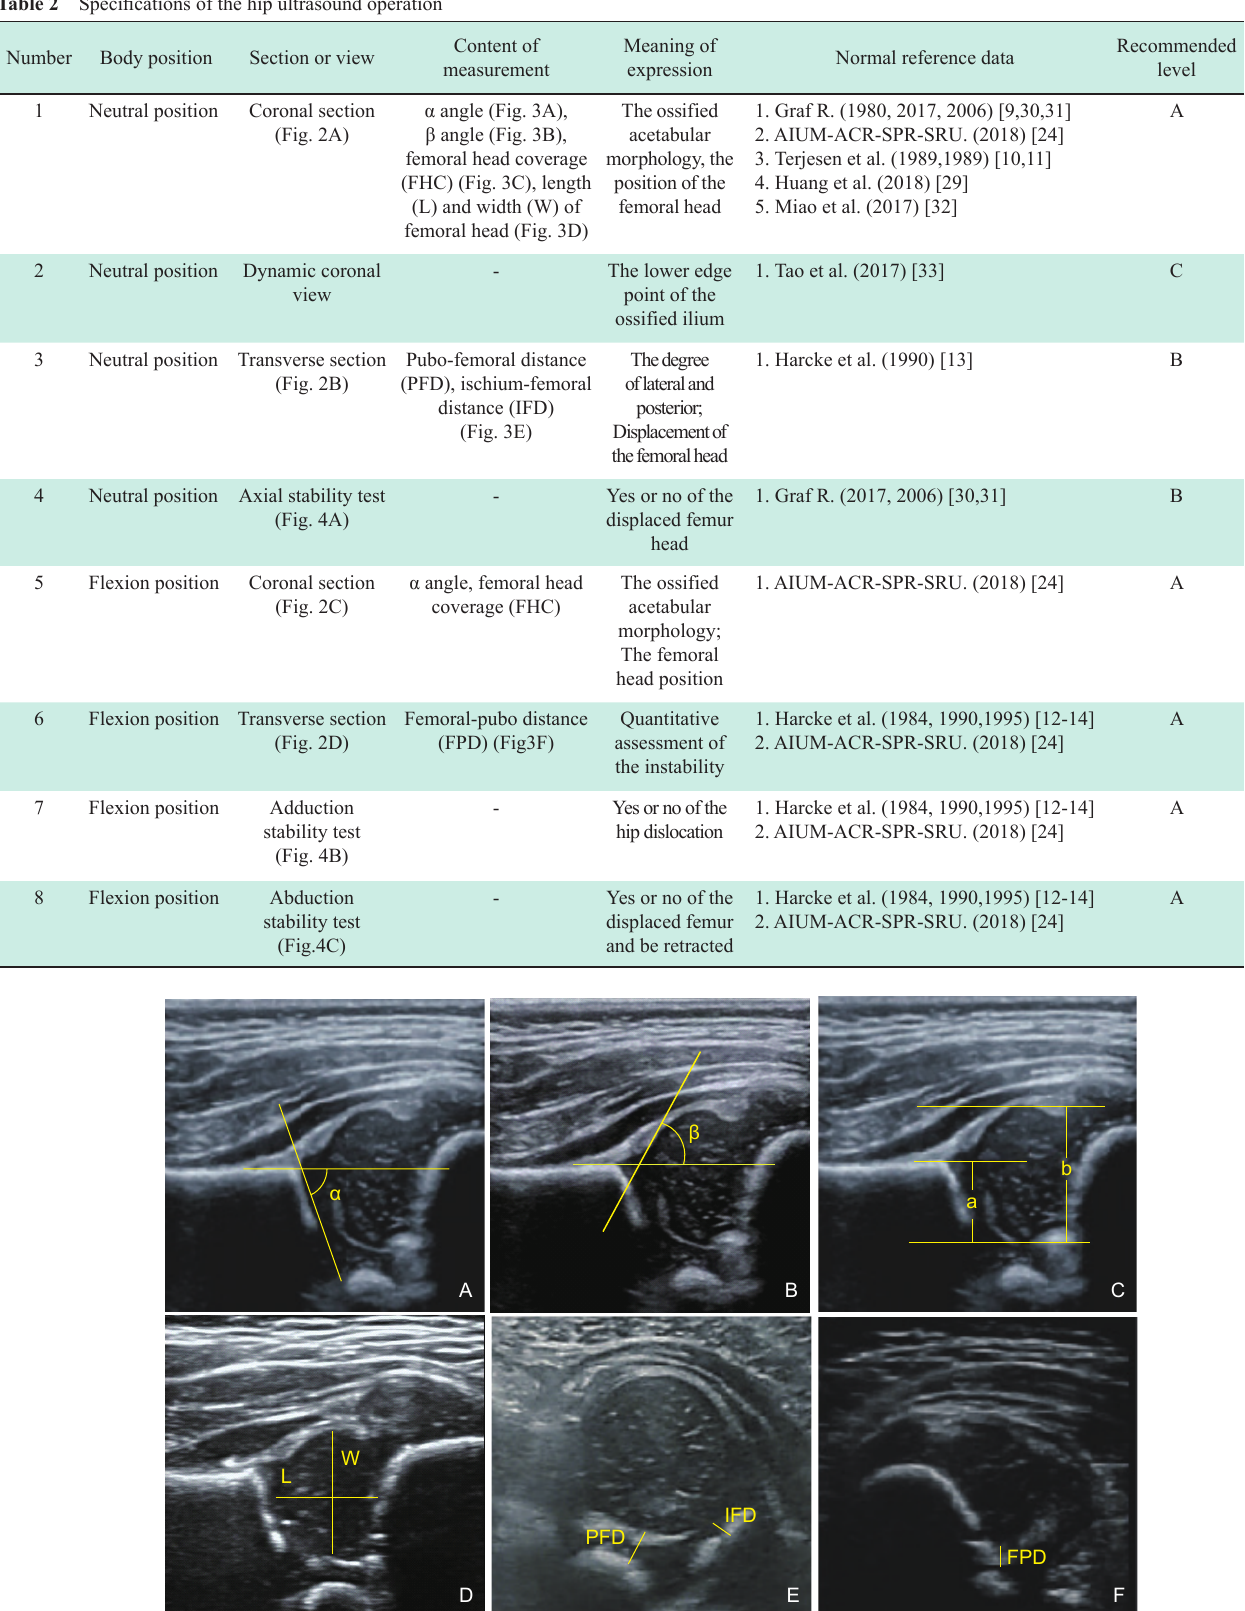
Table 2 Specifications of the hip ultrasound operation